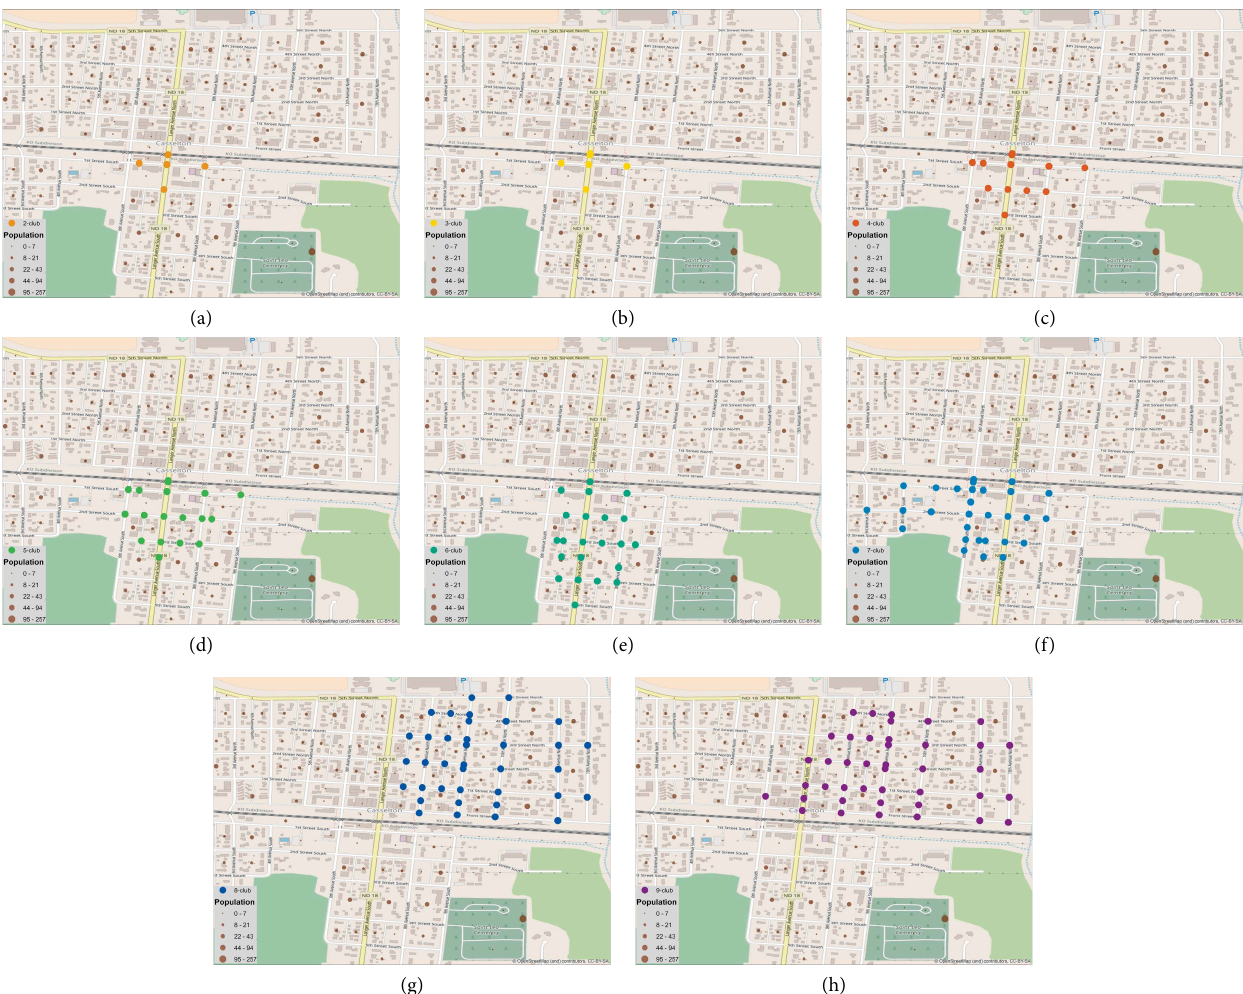
Figure 7: The 𝑘 -clubs obtained from optimizing the model for the city of Casselton. The results are for 푘 = 2, . . . , 9 starting from the top left (for 푘 = 2 ) and ending in the bottom right (for 푘 = 9